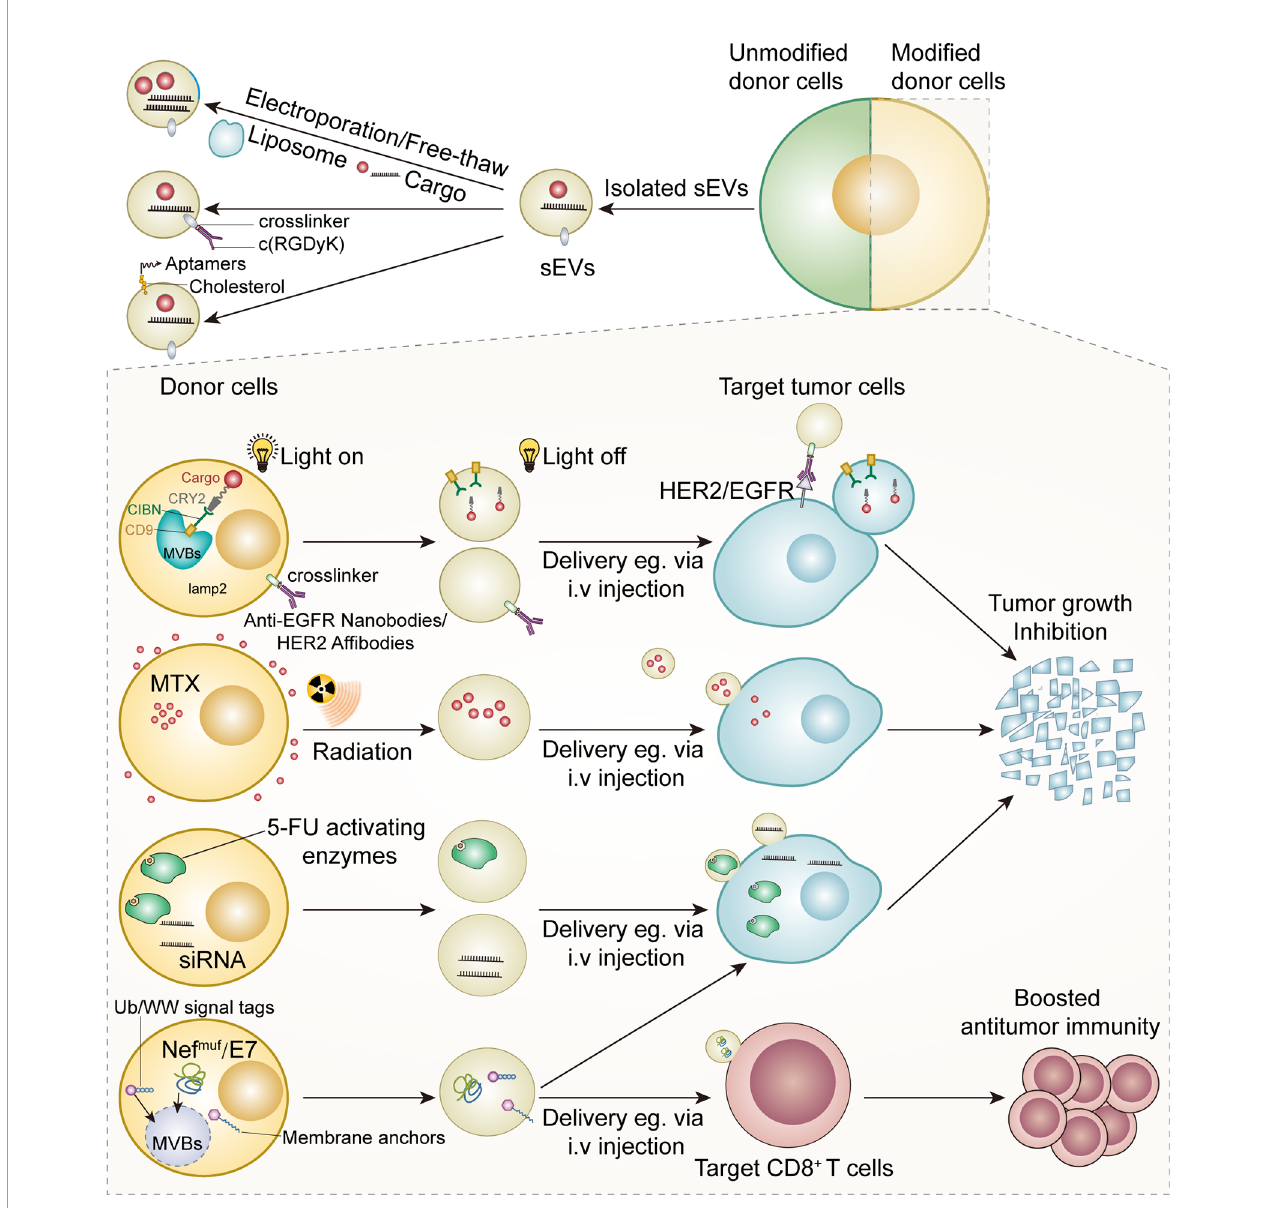
FIGURE 3 | Modi fi ed sEV as anticancer